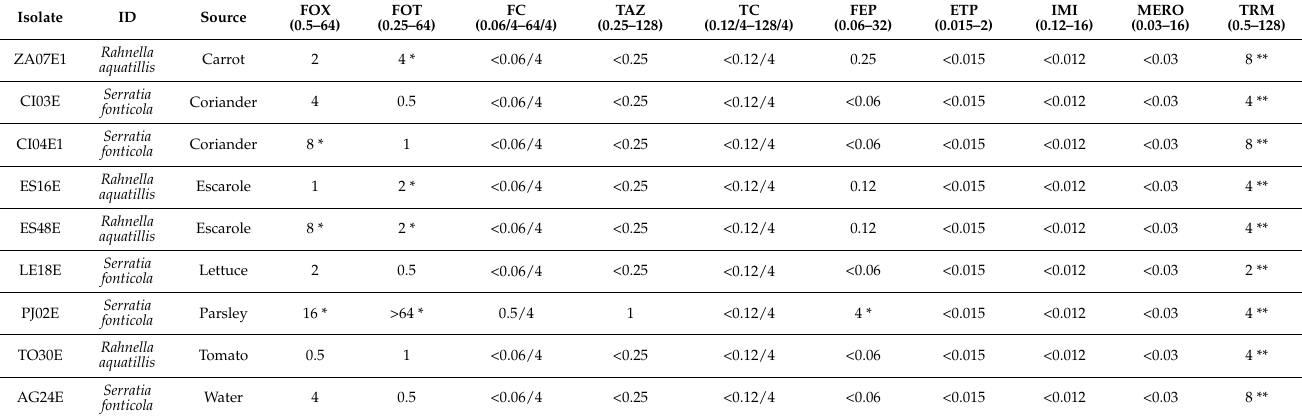
Table 3. Minimum inhibitory concentrations of five S. fonticola and four R. aquatilis